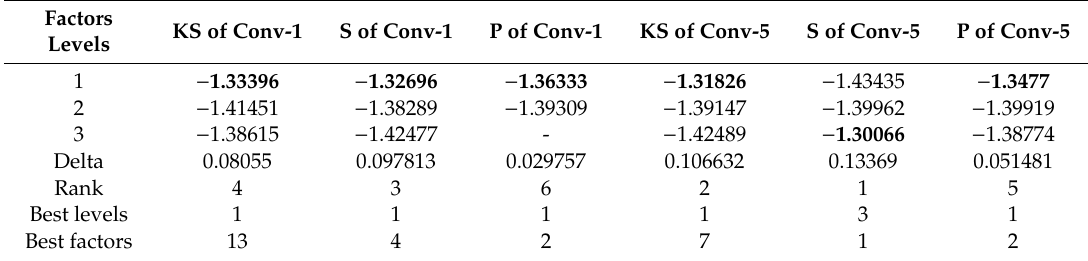
Table 6. Average S / N ratio of each factor and level in CIA data